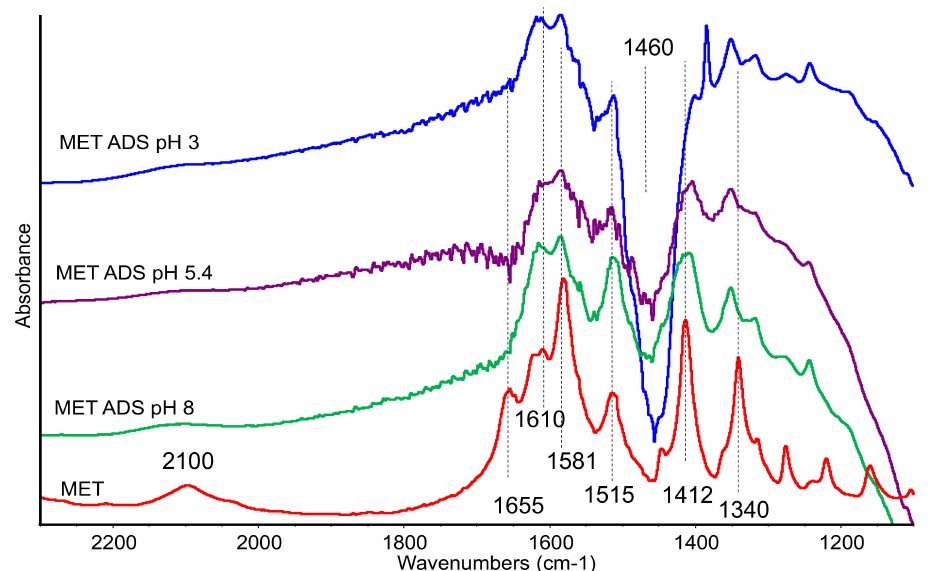
Figure 3. FTIR subtraction spectra (ADS + MET) – (ADS) at different pH. Pure methionine spectrum is also reported as